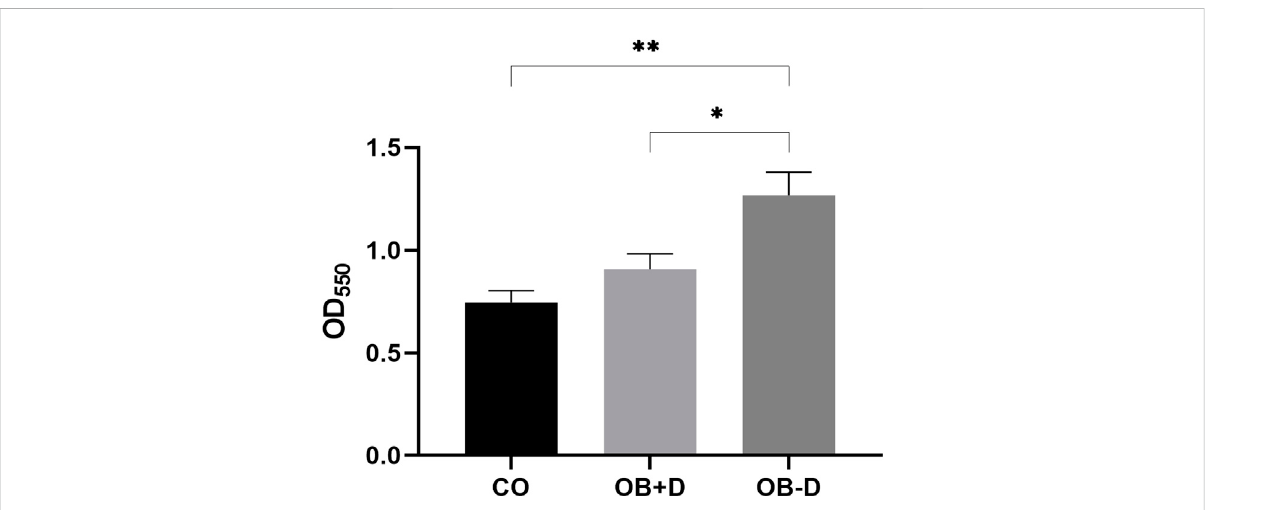
FIGURE 6 Quanti fi cation of collagen deposition. JPCs were cultured for 15 days with control medium (CO) and osteogenic medium with (OB+D) and without (OB − D) dexa. Collagen within monolayers was stained with picrosirius red, and intensities were quanti fi ed by measuring absorption at 550 nm. Mean ± SEM values of OD550 were calculated and compared using one-way ANOVA and Tukey ’ s multiple comparison test (n = 5, * = p < 0.05, ** = p <